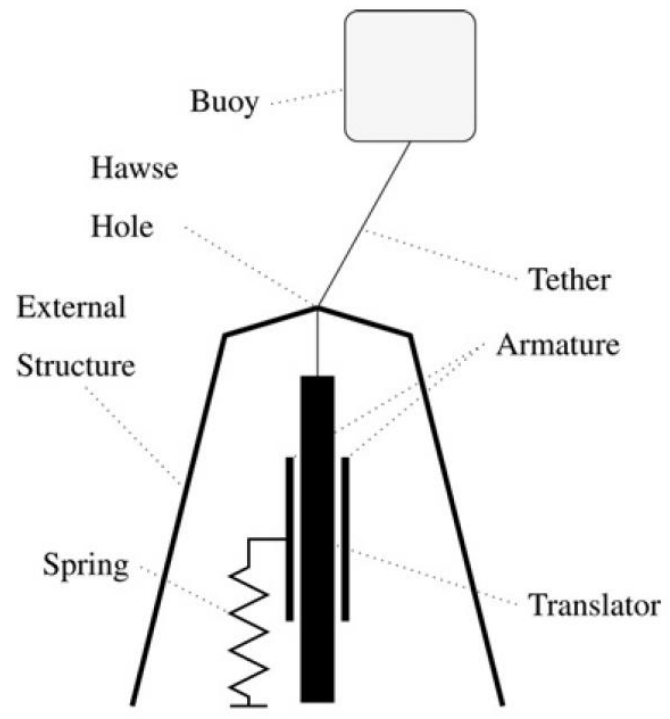
Figure 18. The snapper PTO schematic [71] ..